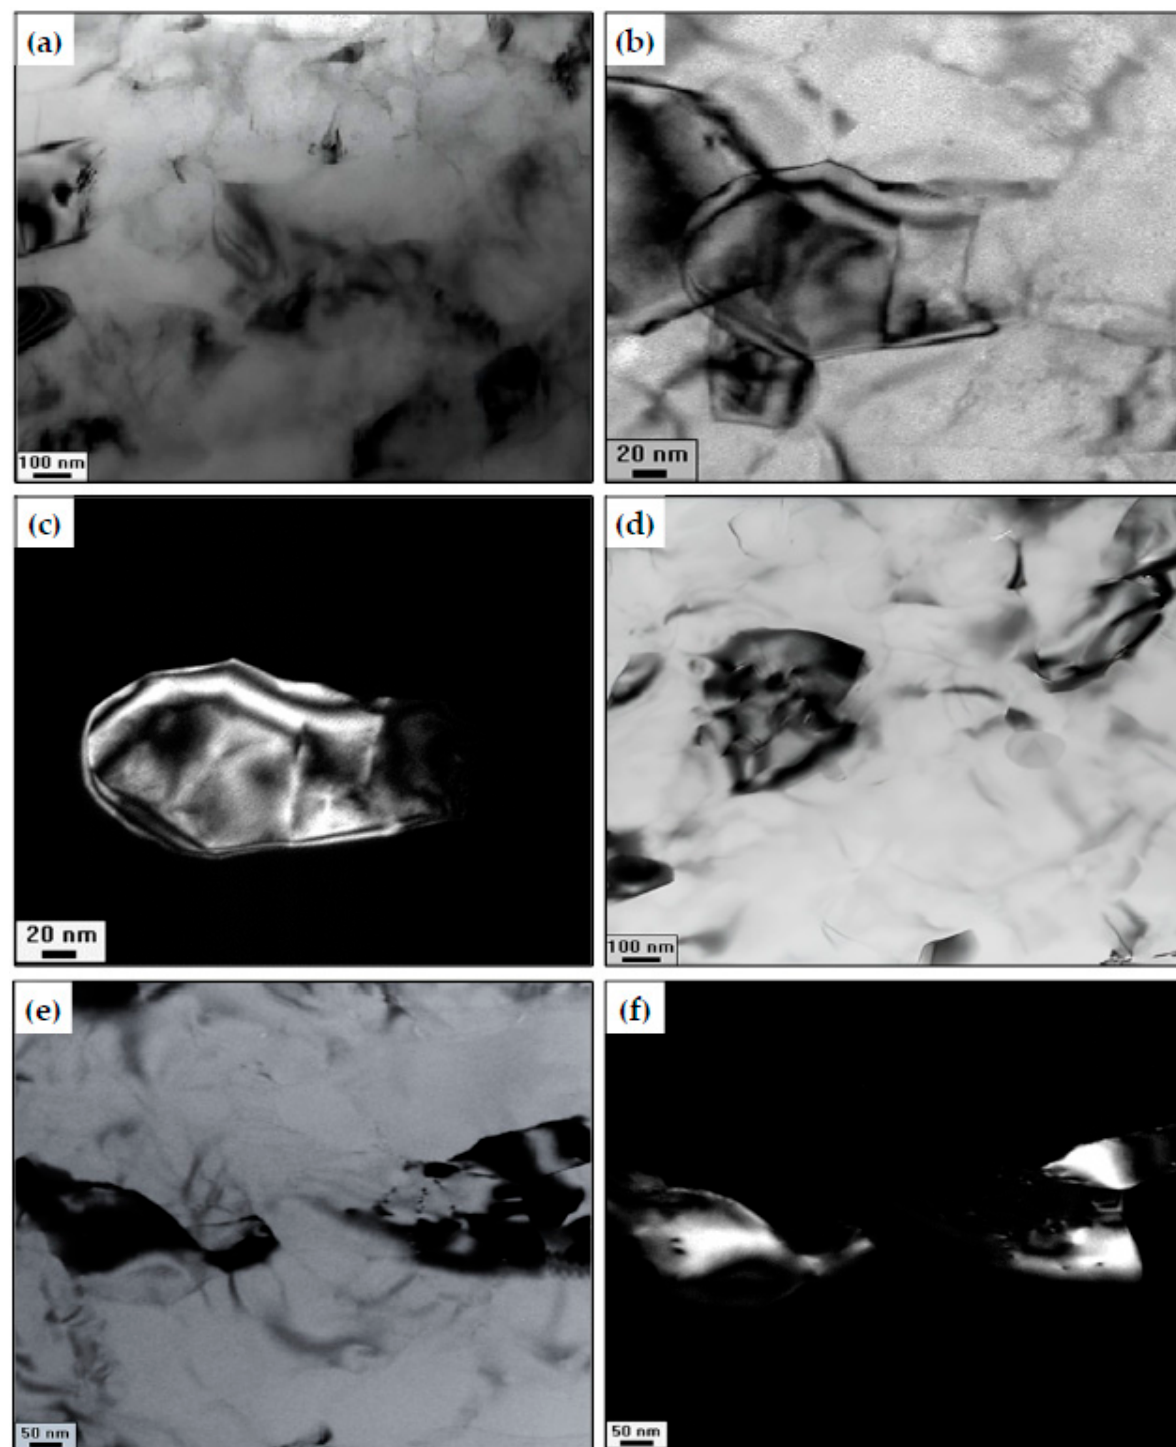
Figure 6. TEM micrographs of ( a ) bright field Al-10% SiC, ( b , c ) bright and dark fields Al-20% SiC, ( d ) bright field Al-10% Al 2 O 3 , and ( e , f ) bright and dark fields Al-20% Al 2 O 3 samples after HPT pro- cessing.